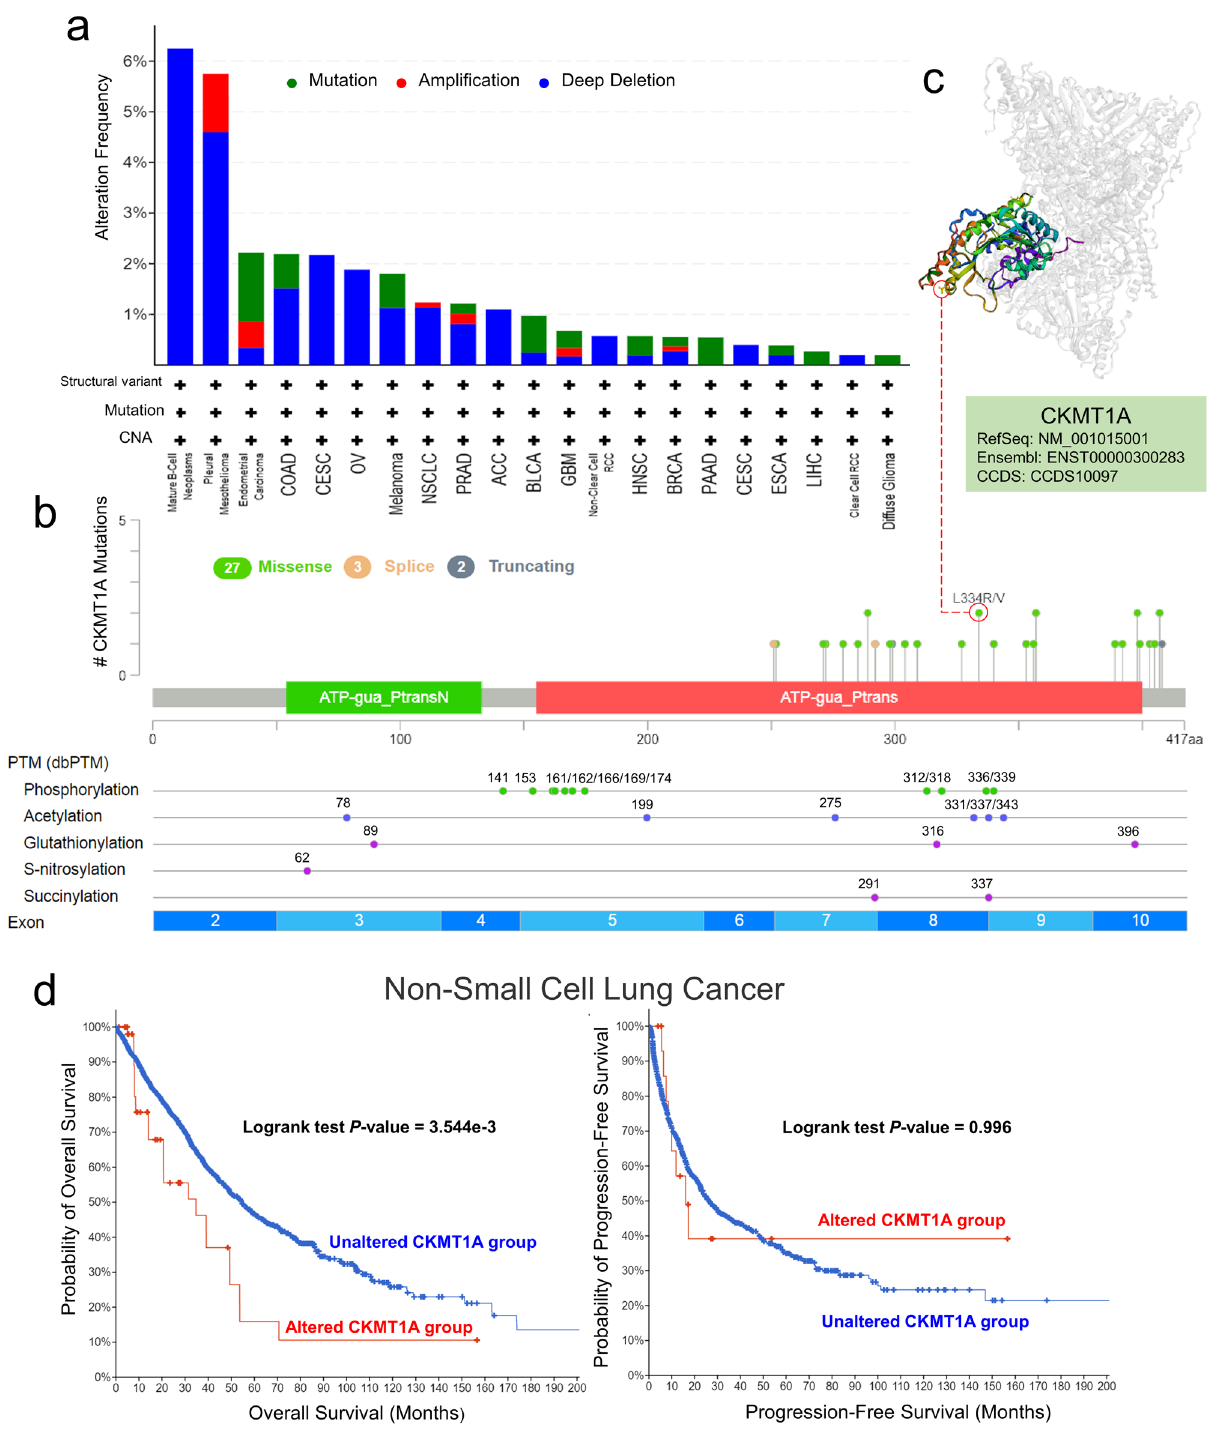
Figure 3. Mutation feature of CKMT1A in different tumors of TCGA. ( a ) The alteration frequency with mutation type of CKMT1A for the TCGA tumors were analyzed by cBioPortal tool. ( b ) The mutation site and PTM of CKMT1A were displayed. ( c ) The mutation site L334R/V in the 3D structure of CKMT1A. ( d ) The correlation between mutation status and overall survival, progression-free survival of Non-Small Cell Lung Cancer were also